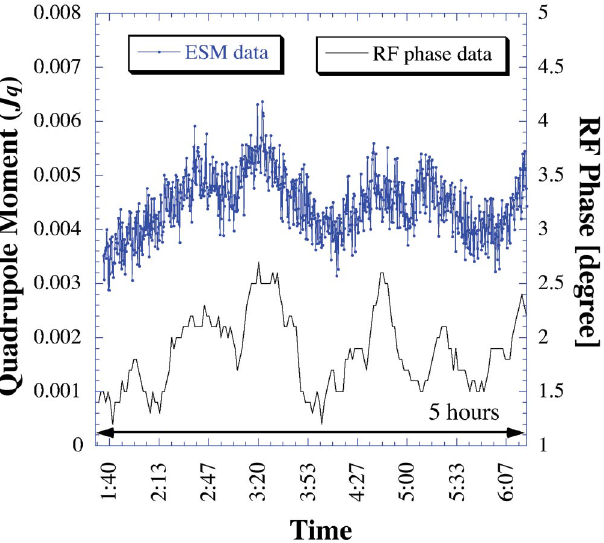
FIG. 6. (Color) Time-trace plots of the energy spread and the rf phase of the sub-booster klystron over 5